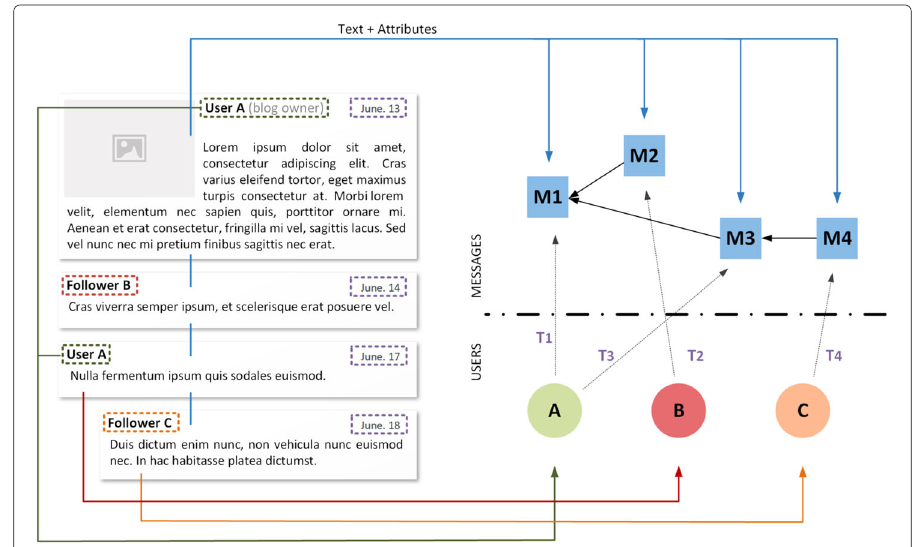
Fig. 5 Model of a blog post as a temporal text network. The original data set contains a blog post M 1 and three comments ( M 2 , M 3 , M 4 ); which are encoded as three individual messages. The three participants on the discussion ( UserA , FollowerB , FollowerC ) are modeled as individual producers. In this case, the edges of the messages indicate the relation between their content